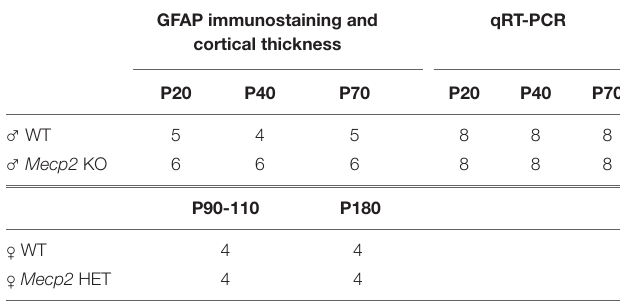
TABLE 1 | Animals used in the